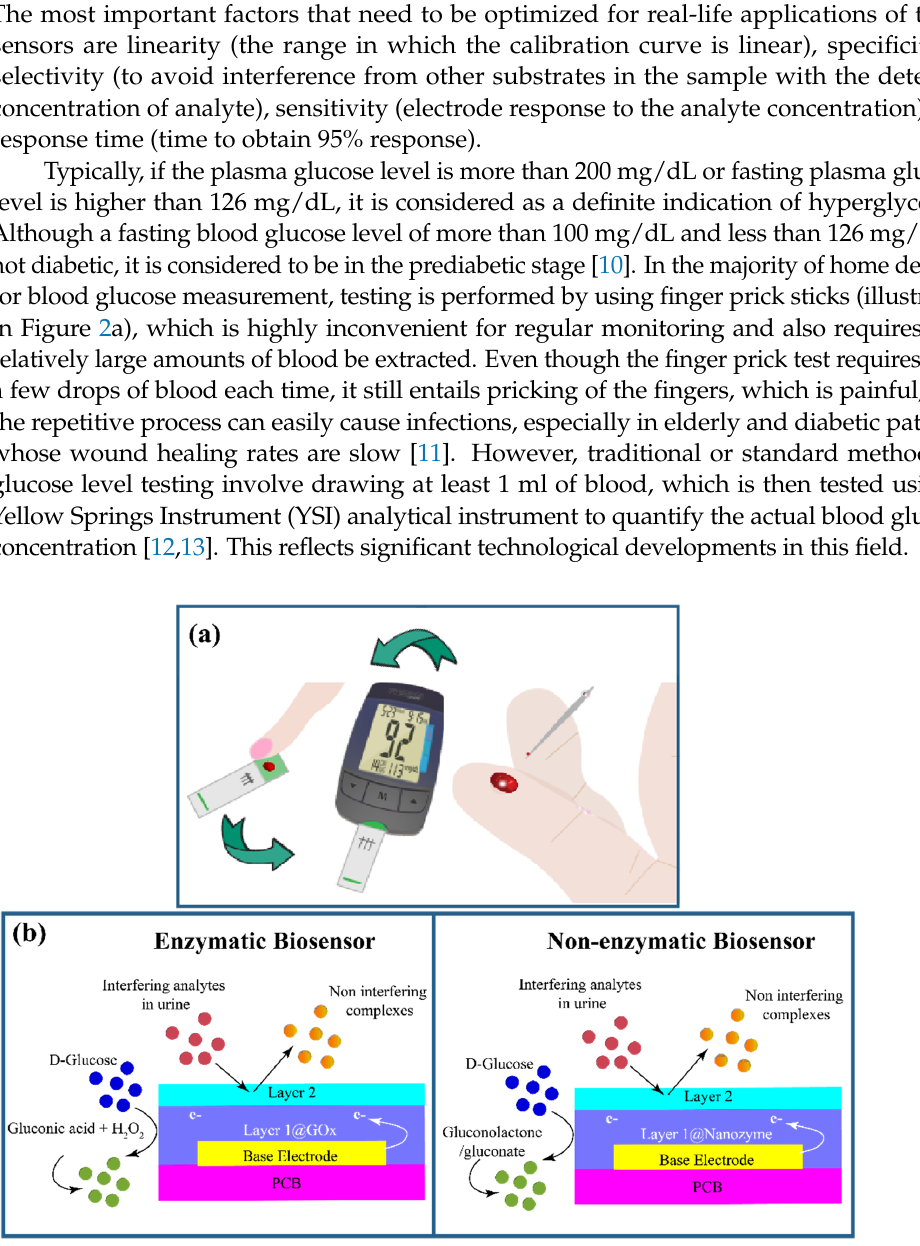
Figure 2. ( a ) Illustration of finger pick test. ( b ) Schematic representation of working mechanisms in enzymatic and non-enzymatic biosensors.